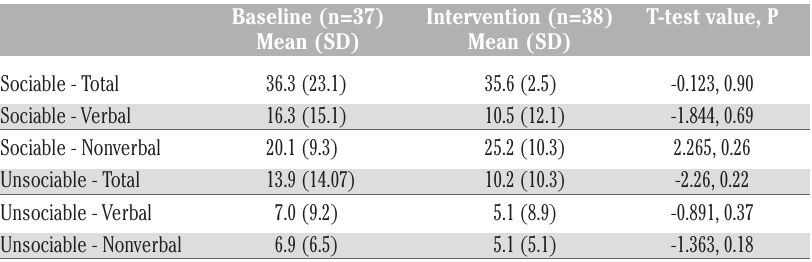
Table 2. Verbal and nonverbal interactions at baseline and during music therapeutic care